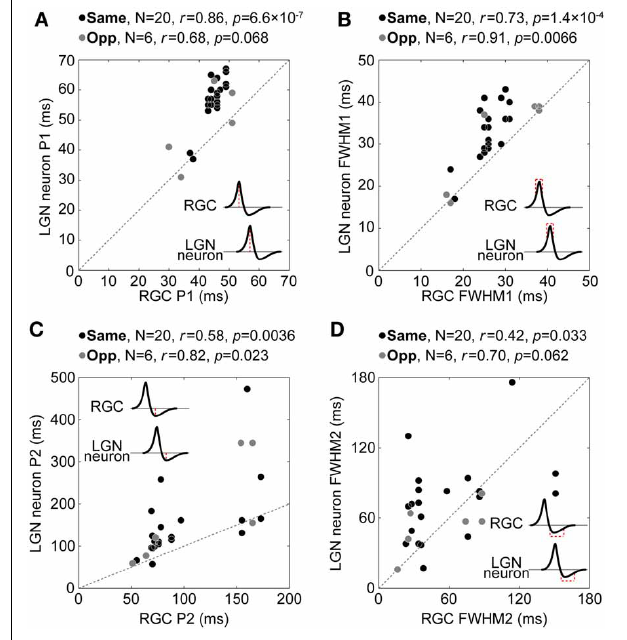
FIGURE 9 | Relationship between temporal RF structures of retinogeniculate-connected pairs. Relationship between P1 (A) , FWHM1 (B) , P2 (C) , and FWHM2 (D) for RGCs (horizontal axis) and LGN neurons (vertical axis). Black and gray circles indicate same- and opposite-response-sign pairs, respectively. Insets indicate schematic temporal RF structures. Note that the scale of the horizontal axis and that of the vertical axis are not equal in (C)